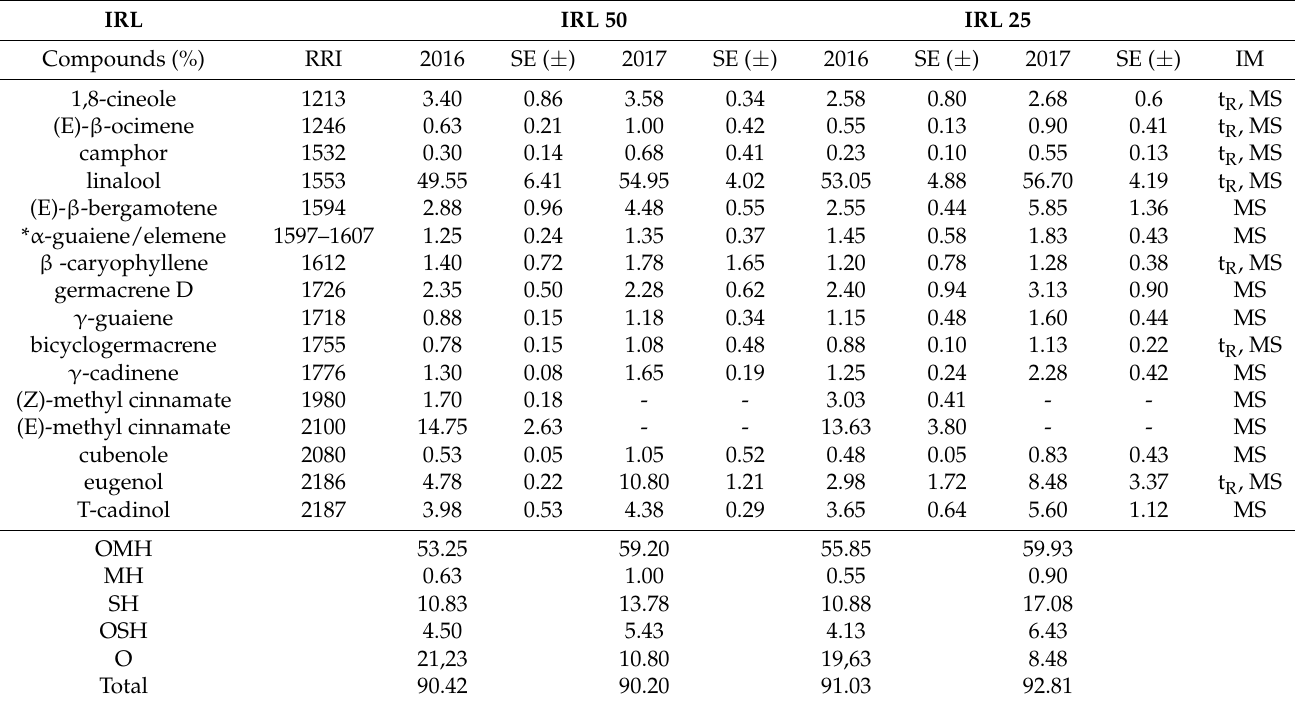
Table 4. Essential oil components of O. basilicum L. according to different IRLs in 2016 and 2017 with- out SM. (continued).